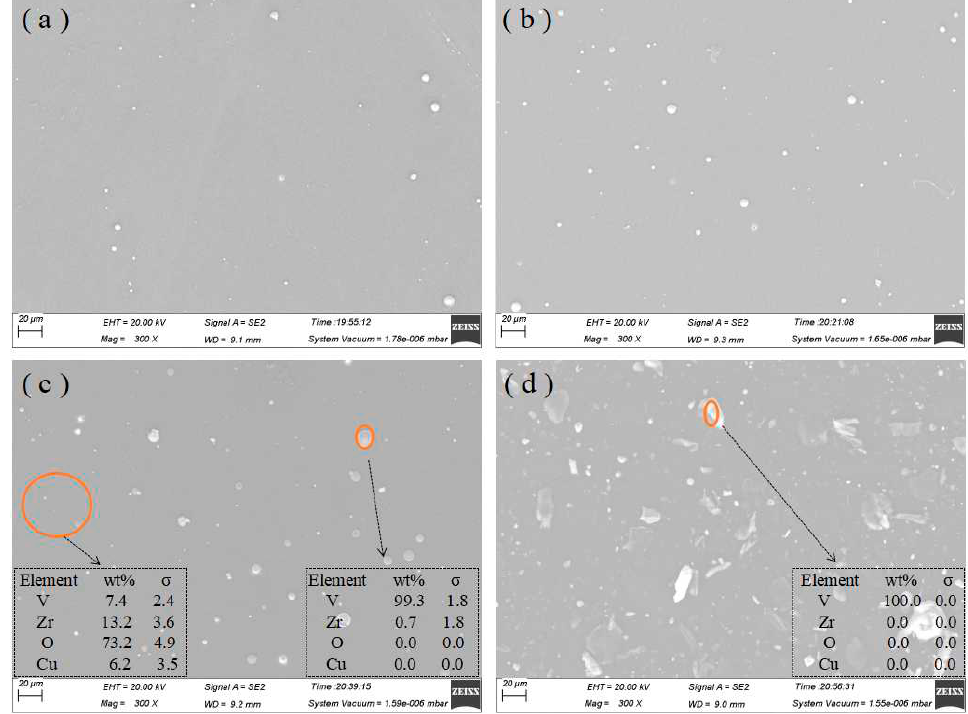
Figure 3. Scanning electron microscopy (SEM) images and Energy-dispersive X-ray spectroscopy (EDS) element distribution table (insets) of VO 2 films deposited on Cu 50 Zr 50 buffer layers with different thicknesses. ( a ) No buffer layer ( b ) 40 nm thickness ( c ) 80 nm thickness ( d ) 160 nm